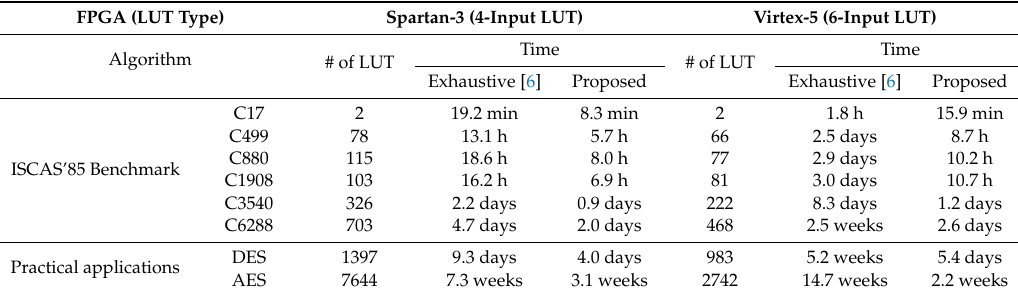
Table 2. Comparison of recovery time for ISCAS’85 benchmarks and practical